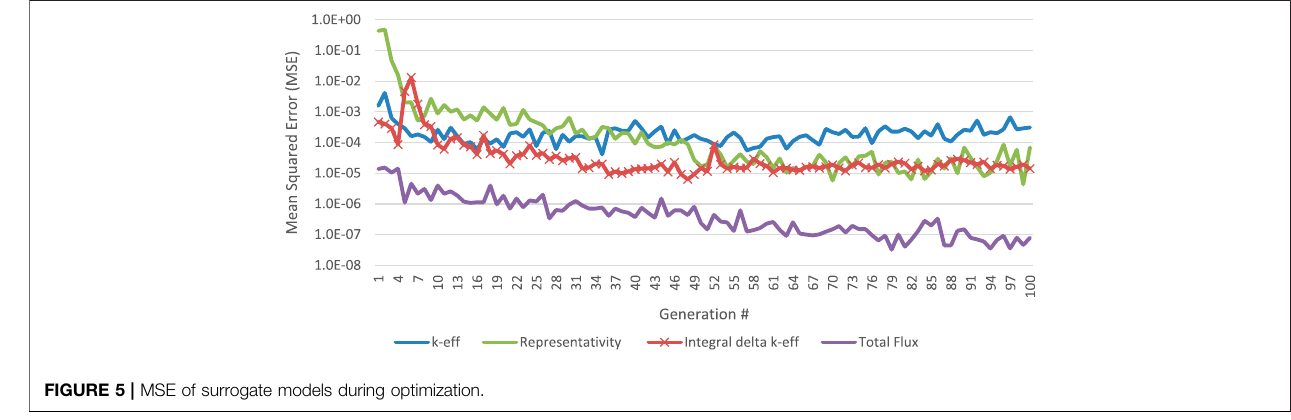
FIGURE 5 | MSE of surrogate models during